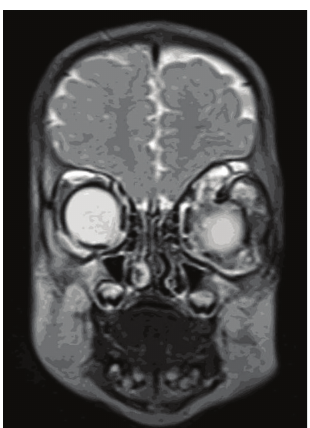
Figure 6: Orbital CT scan at one year of age showing the proptosis of the globe and some cystic spaces between the extraocular muscles in the left